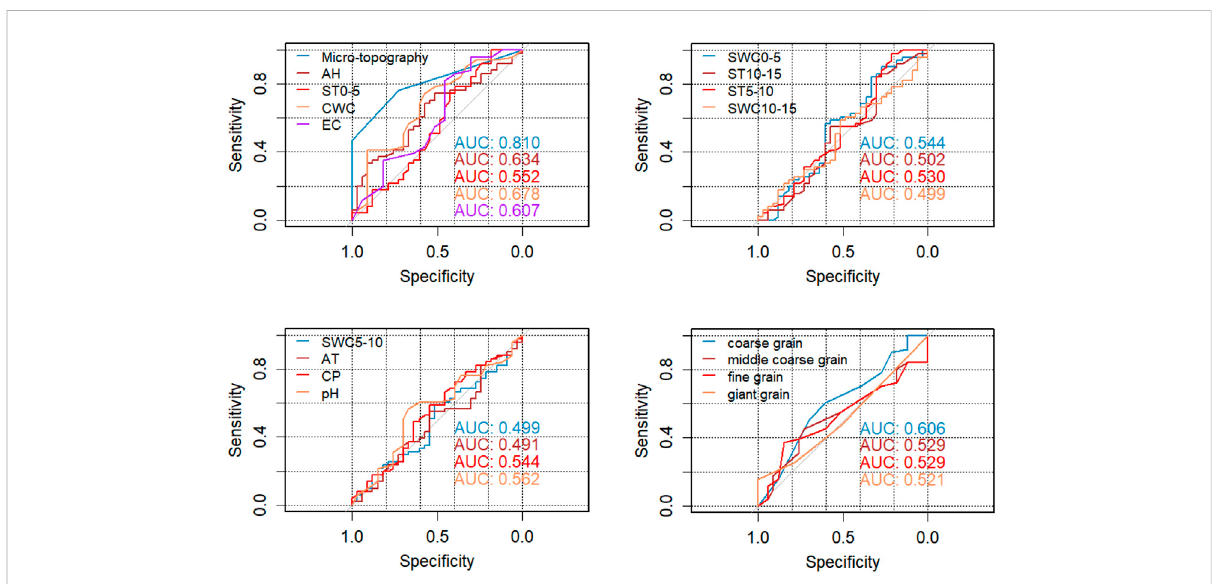
FIGURE 6 Receiver operating characteristic (ROC) curve of environmental conditions and micro-topography types as predictors for the seedling emergence classi fi